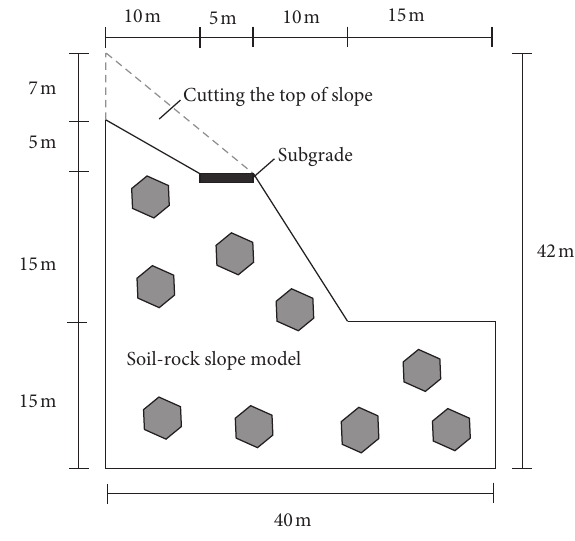
Figure 11: Basic analytical